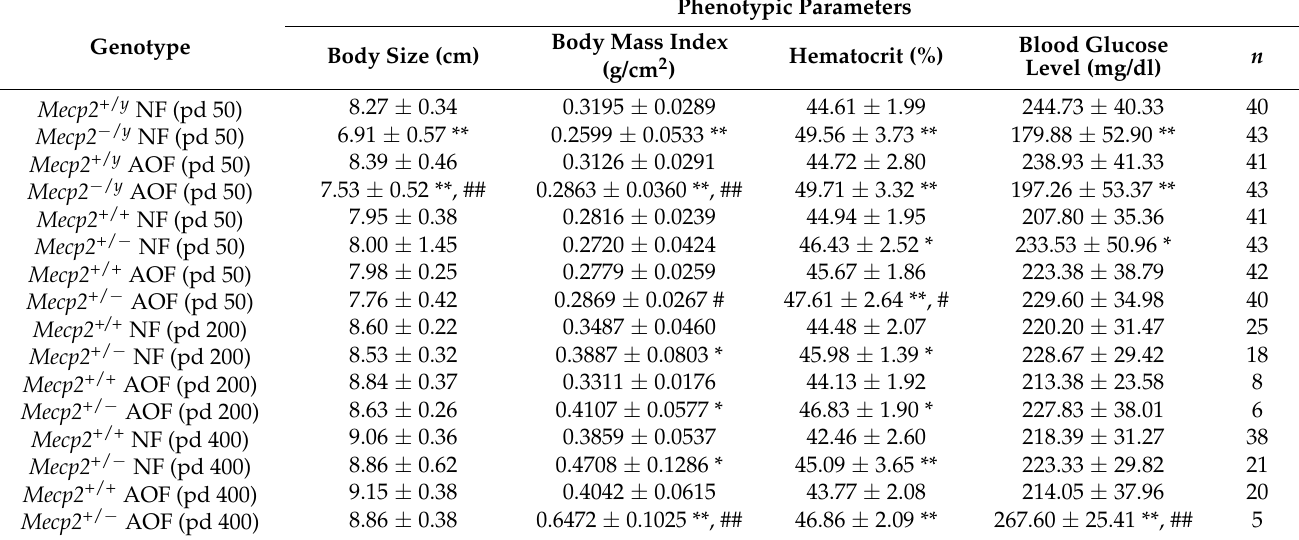
Table 1. Phenotypic parameters distinguishing WT and Mecp2 -mutant mice and their modulation via antioxidant food (AOF). Listed data are means ± standard deviations (SDs); n refers to the number of mice studied. Significant genotype-related differences among WT and Mecp2 -mutant mice are indicated by asterisks (* p < 0.05, ** p < 0.01). Those significant differences among matching genotypes that arose from AO treatment are identified by crosshatches (# p < 0.05, ## p <